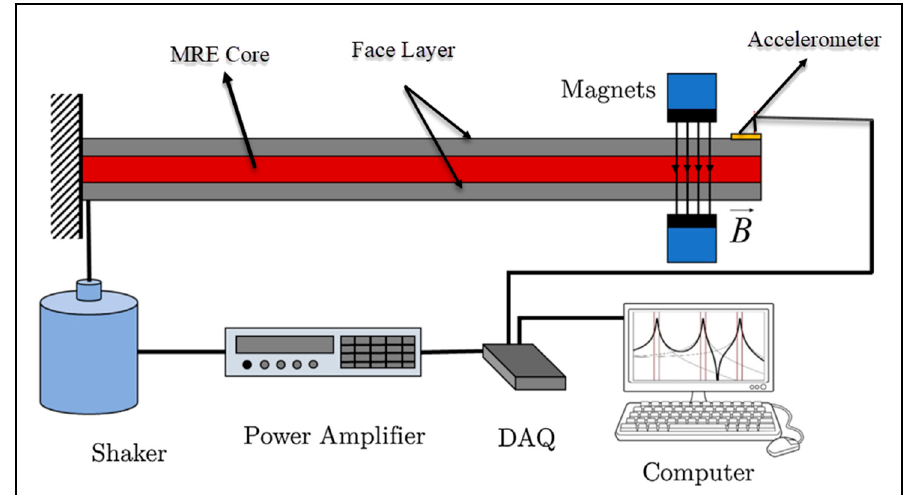
Figure 5. Schematic typical experimental setup of MRE sandwich beam.